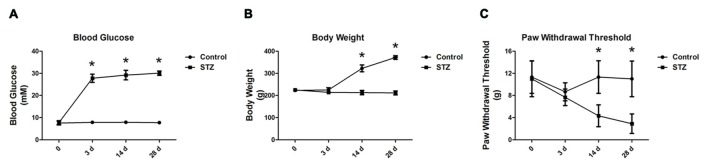
Streptozotocin (STZ)-induced diabetic rats exhibit elevated blood glucose concentration, reduced body weight and decreased paw withdrawal thresholds (PWTs). Changes in blood glucose concentration (A), body weight (B) and PWTs (C) in rats after STZ injection from day 3 to day 28. Mean ± SD, n = 6 per group, *p < 0.05 vs. non-diabetic control rats.